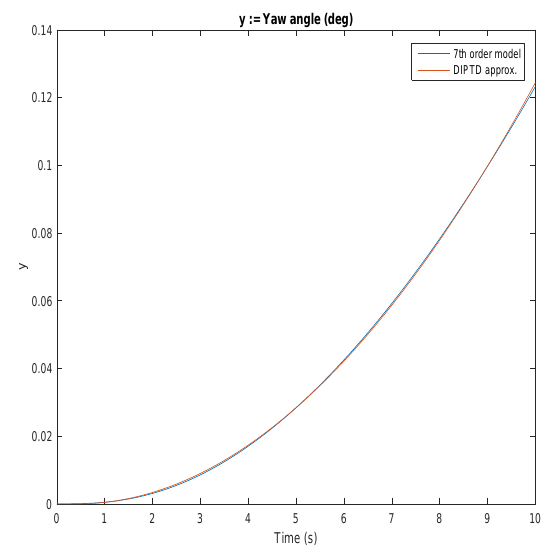
Figure 16: Comparing step responses of the numeri- cally linearized 7th order model in Eq. (51) vs. the DIPTD process with K = 0 . 0027 and τ = 0 . 4231. Shows the optimal DIPTD model, i.e. optimal in the sense that the MSE between the two step responses is minimized.